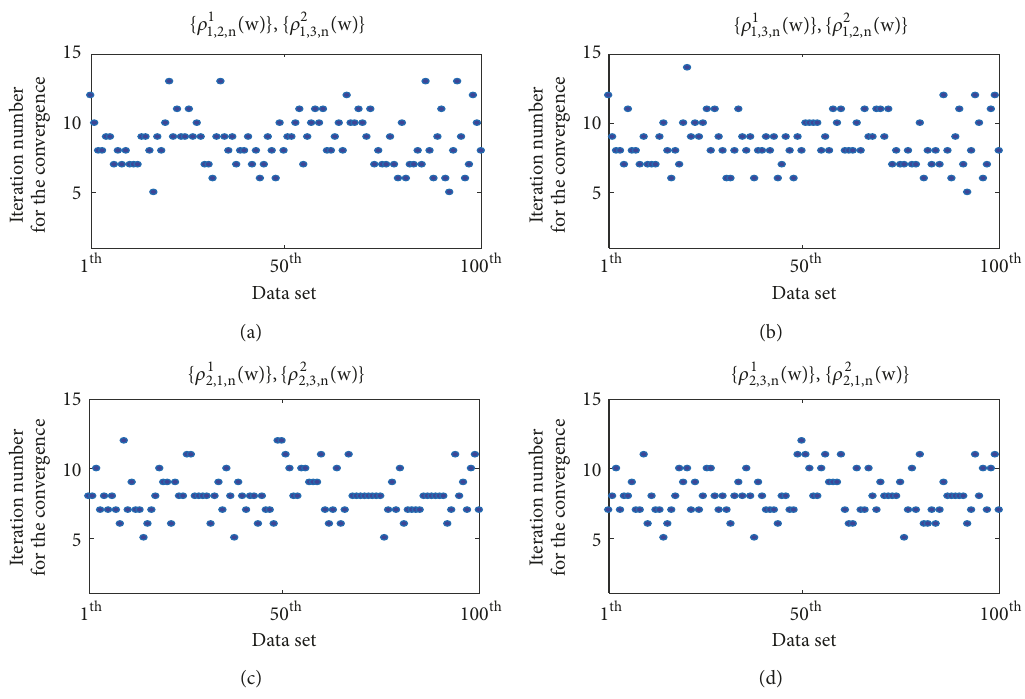
Figure 5: Iteration number for the convergence. (a) The system of recursive relations for 𝜌 𝜐 1,2,𝑛 (𝑤) and 𝜌 𝜐 1,3,𝑛 (𝑤) (𝜐 = 1, 2, 𝑤 = −1, 0, 1) converges within 10 iterations for tolerance 10 −10 . Symbols and data in Figures 5(b), 5(c), and 5(d) have similar meanings as in Figure 5(a).